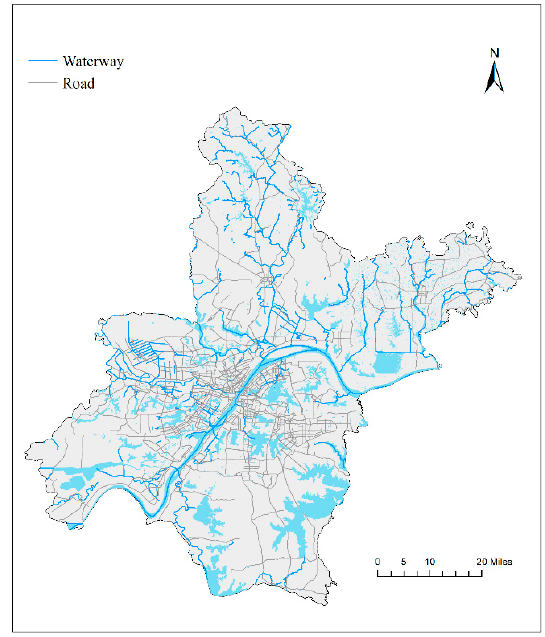
Figure 1. Map of the study site.